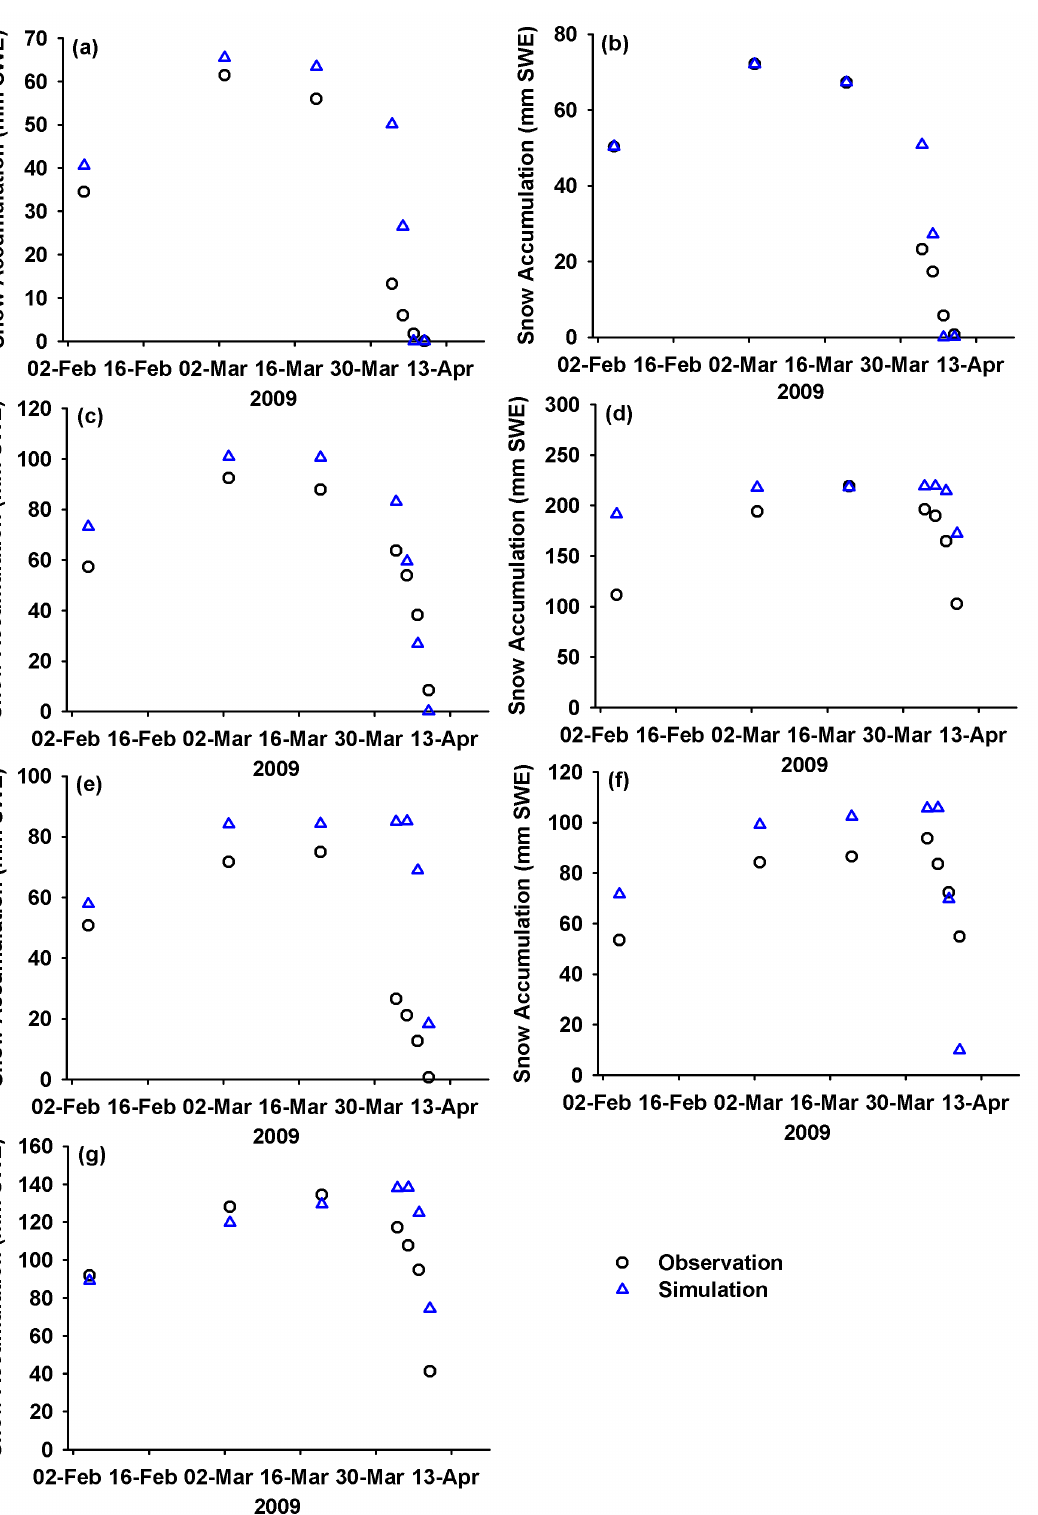
Fig. 8. Comparisons of the observed and simulated snow accumulation (SWE) during 2009 simulation period for seven HRUs in the sub- basin 1 of Smith Creek Research Basin. (a) fallow, (b) stubble, (c) grassland, (d) river channel, (e) open water, (f) woodland, and (g)